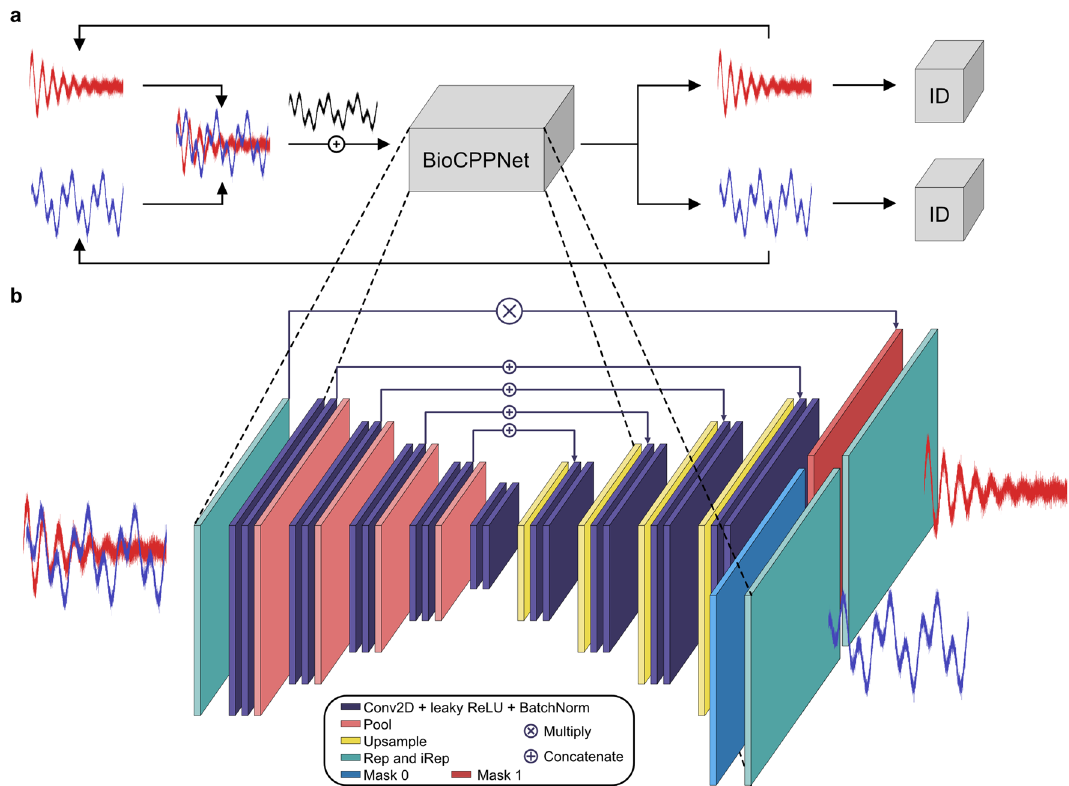
Figure 1. ( a ) Schematic overview of the BioCPPNet pipeline. Source vocalization waveforms are overlapped in time and mixed additively. BioCPPNet operates on the mixture waveform, yielding predictions for the separated waveforms, which are compared to the source ground truths, up to a permutation. The estimated waveforms are classified by the identity classification model 24 (ID) to compute the downstream classification accuracy metric. ( b ) Block diagram of the BioCPPNet architecture. The input mixture waveform is transformed to a learnable or handcrafted representation (Rep), which then passes through a 2-dimensional U-Net 52 composed of a contracting encoder path and an expanding decoder path with skip connnections. The encoder path consists of sequential downsampling convolutional blocks, each of which is constructed using two convolutional layers (Conv2D) with leaky ReLU activation and batch normalization (BatchNorm) followed by a max pooling. The decoder path employs upsampling convolutional blocks, consisting of an upsampling and skip connection concatenation followed again by the Conv2D layers with leaky ReLU and BatchNorm. The U-Net predicts masks (Mask 0 and Mask 1), the number of which is determined by the number of sources ( N ), that are multiplicatively applied to the original mixture representation. The predicted time-frequency representations of the separated waveforms are inverted with learnable or handcrafted inverse transforms (iRep) to output raw waveforms. All schematic diagrams were created using Affinity Designer (version 1.8.1) https:// affin ity. serif. com/ en- us/ desig